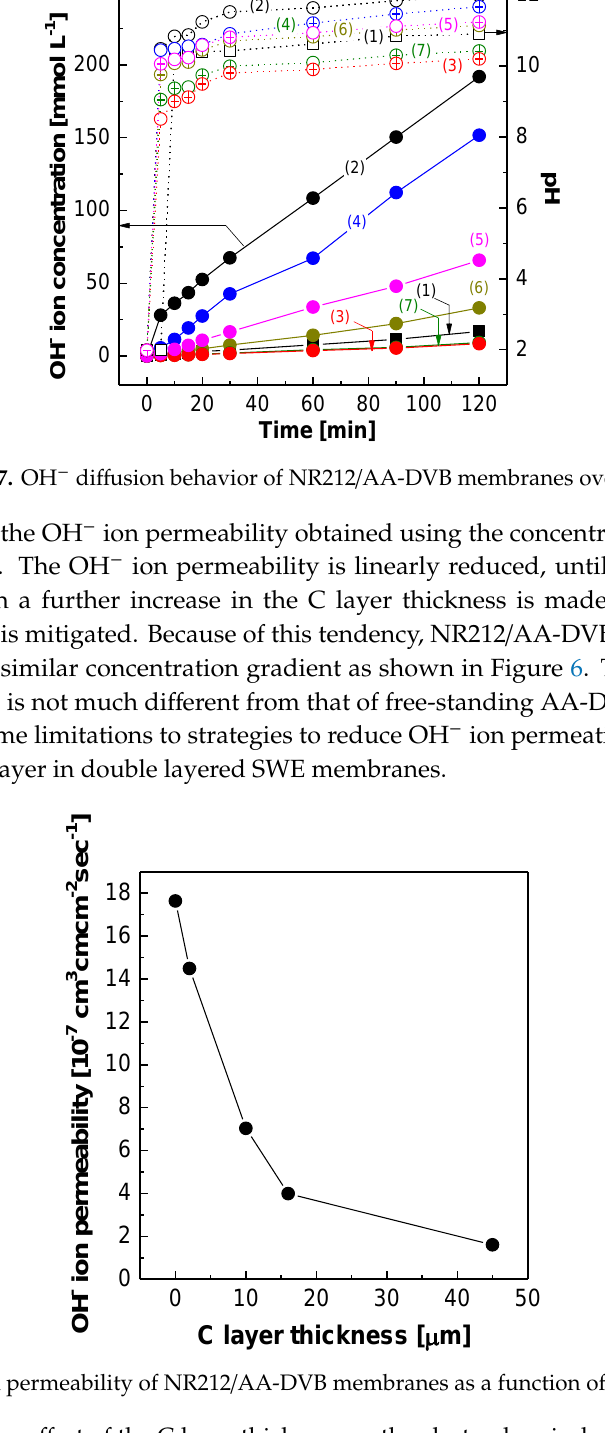
Figure 8. OH − ion permeability of NR212 / AA-DVB membranes as a function of C layer thickness.